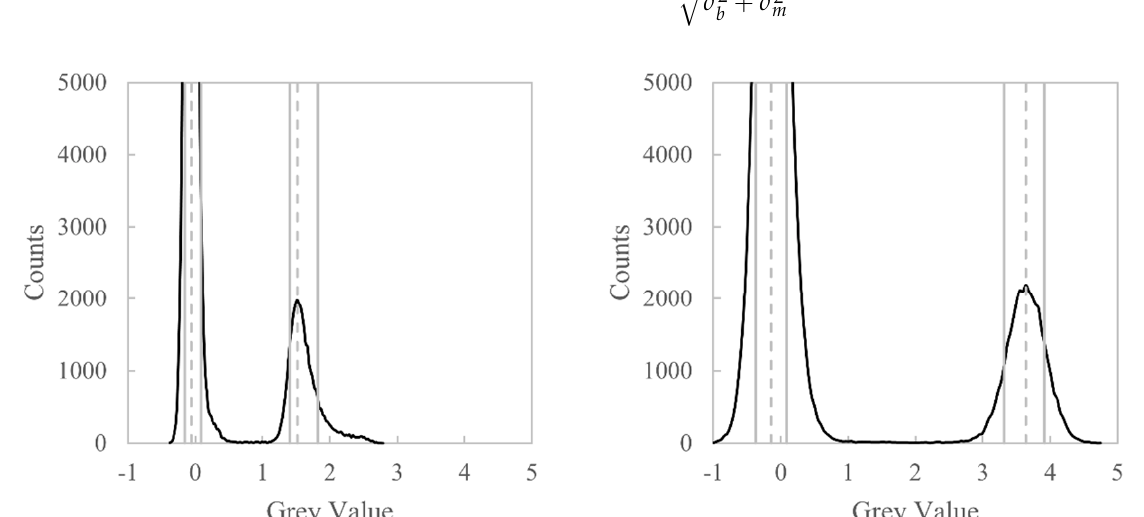
Figure 14. Comparison of line profiles drawn across the central row of the CT images in Figure 13.